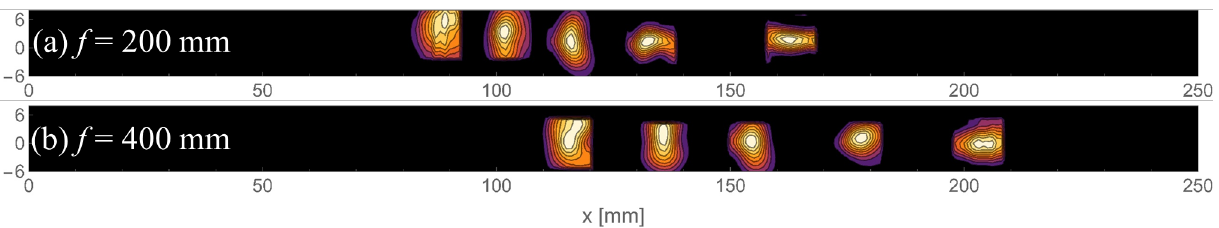
Figure 6. Intensity distributions of the focal spots measured for different radiation frequencies inscribed into the common xy diagrams illustrating focal plane for the focal length ( a ) f = 200 mm and ( b ) f = 400 mm.